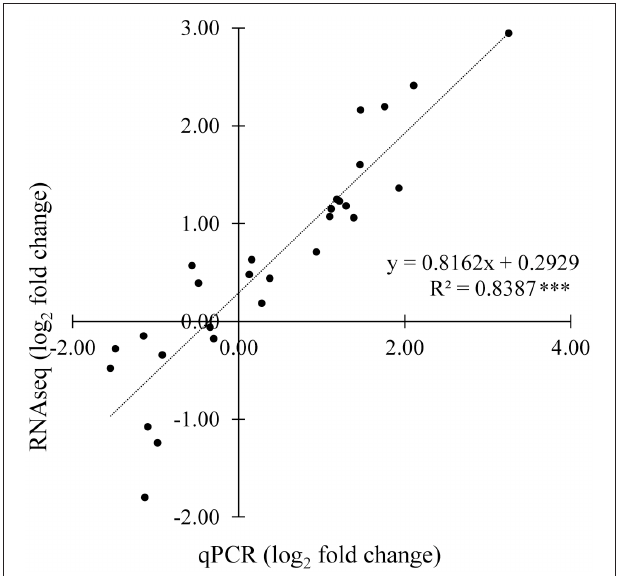
FIGURE 4 | Correlation of differential expression ratios (log 2 fold change) obtained from RNAseq and quantitative PCR (qPCR) analyses. Fourteen genes belonging to the sesquiterpenoid and triterpenoid pathway (Table S2) were arbitrarily chosen and their expression was monitored in Mol and Gal landraces in Apulia and Lazio areas. For a given unigene, RNAseq fold change refers to the ratios of RPKM values of Mol to Gal, whilst qPCR fold change is the relative expression of Mol normalized to those of Gal. R 2 , coefficient of determination; ***, significant correlation at P < 0.001.